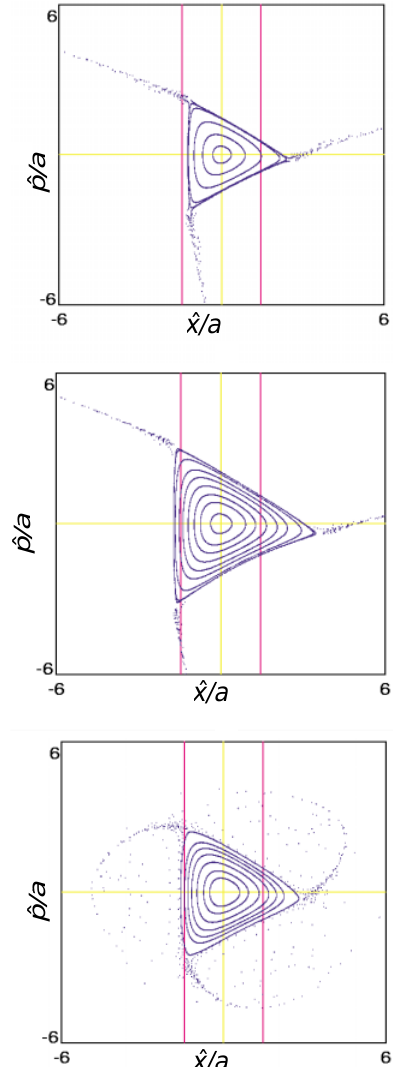
a ˆ j (cid:1) ˆ a 2 (cid:1) 2 (cid:2) 2 ˆ j (cid:1) 3ˆ a 2 (cid:3) is the coefficient of the third-order